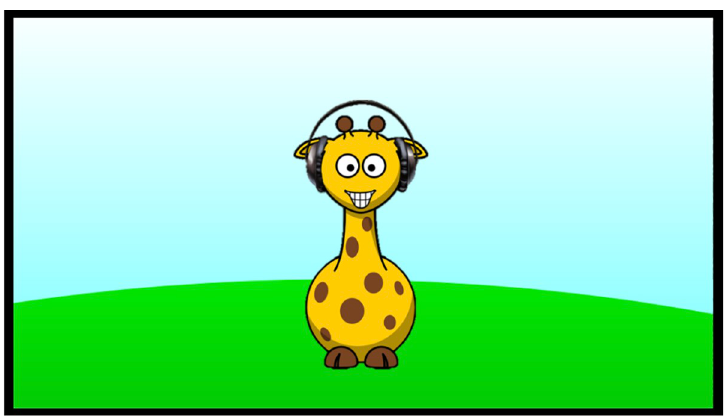
Fig 4. Graphical display for the c-RST. Giraffe’s headphones are highlighted during ‘listen’ phase, and hoof is highlighted during ‘listen + tap’ phase. Image is presented in full colour within the actual